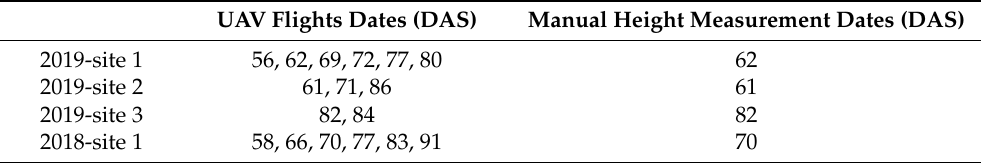
Table A2. Dates and days after seeding (DAS) for UAV flights and manual height measurement for field pea plots in 2018 and